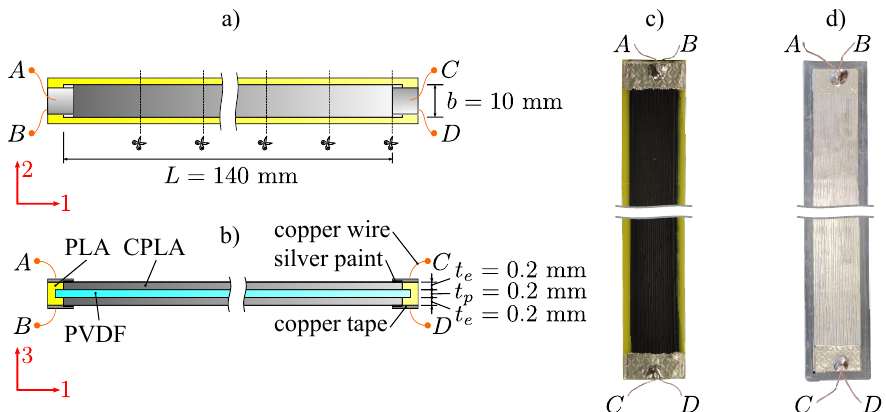
Figure 6. Three-dimensionally-printed specimens A and B: ( a ) top view, ( b ) side view, ( c ) 3D-printed PE sensor (specimen A), ( d ) ideal PE sensor (specimen B).